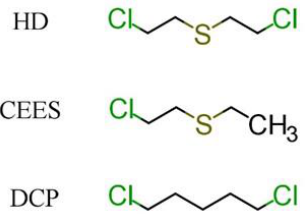
Figure 3. Sulfur mustard (HD) and its simulants: 2-chloroethyl ethyl sulfide (CEES) and 1,5-dichloropentane (DCP).